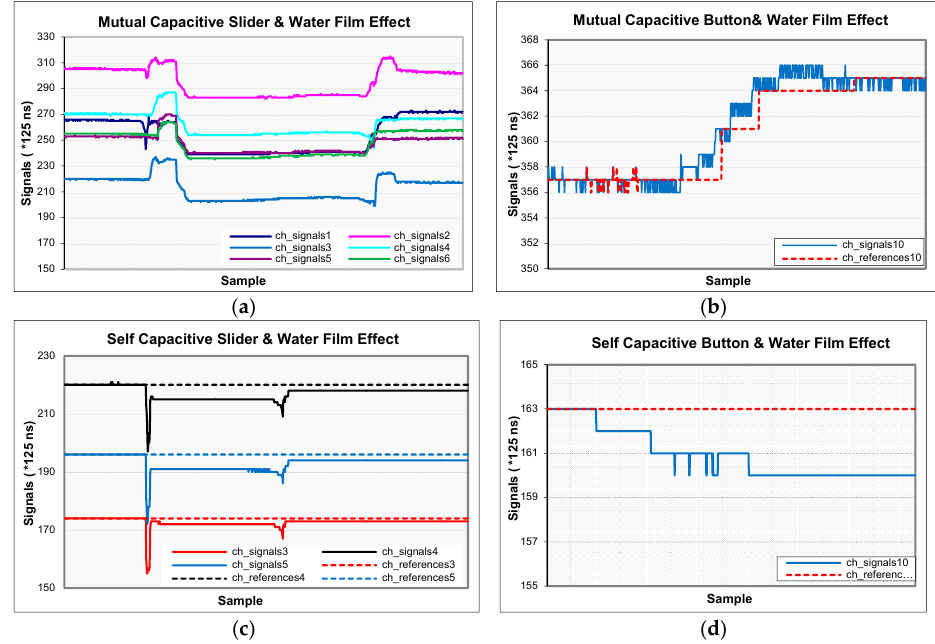
Figure 11. Signal changes as a result of water film test on two types of sensors: ( a ) The slider is composed of 6 channels; ( b ) on the 10th channel; ( c ) the slider consists of 3 channels; ( d ) on the 10th channel of self-capacitance sensors. (b) and (d) are related to a single button.